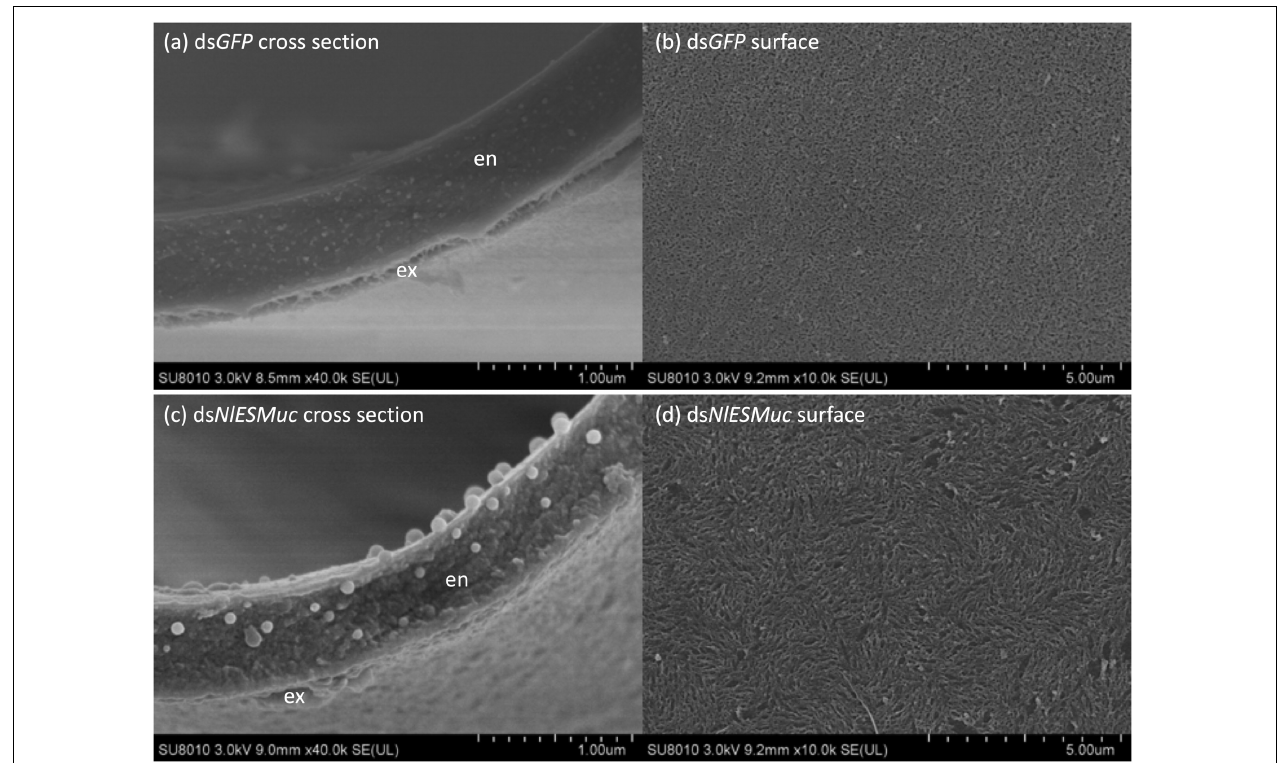
FIGURE 6 | Scanning electron microscope observation of developed oocytes from dsGFP (control) and dsNlESMuc adult female BPH. (a,c) Cross-section of the developed oocytes ( n = 3). All observed dsNlESMuc eggshells had a looser structure, and there were many small droplets of ∼ 0.1- µ m diameter. En, endochorion; ex, exochorion. (b,d) The surface of developed oocytes ( n = 5). dsNlESMuc oocytes had rougher